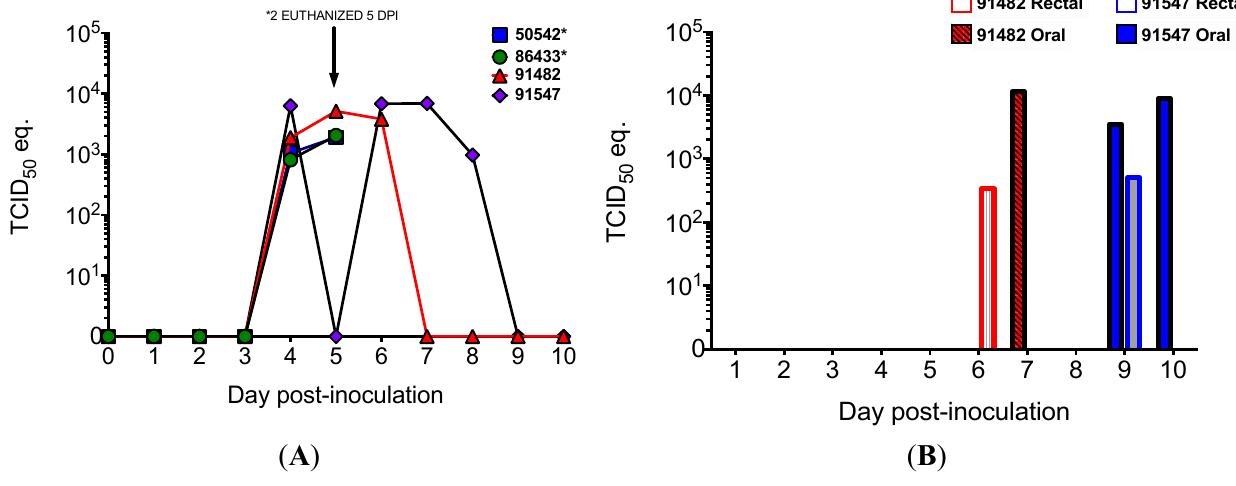
Figure 3. Viral loads, as determined by Q-RT-PCR and expressed as 50% tissue culture infective dose (TCID 50 ) equivalents per mL, in four bats inoculated with Marburg virus in the Pilot Study and euthanized at 5 ( n = 2) and 10 ( n = 2) DPI. ( A ) Marburg viral RNA in blood is evidence of viremia in all four Marburg virus-inoculated bats; ( B ) Marburg viral RNA in oral (filled bars) and rectal (open bars)